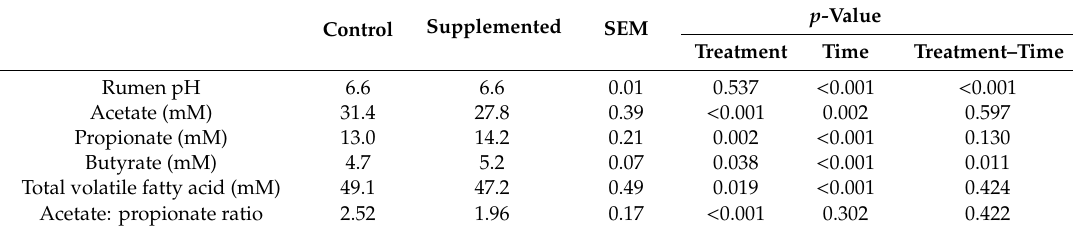
Table 1. E ff ects of a 4.5% licorice root extract supplementation on the daily means of ruminal pH and volatile fatty acid concentration of Karakul sheep fed cottonseed hull-based diets.